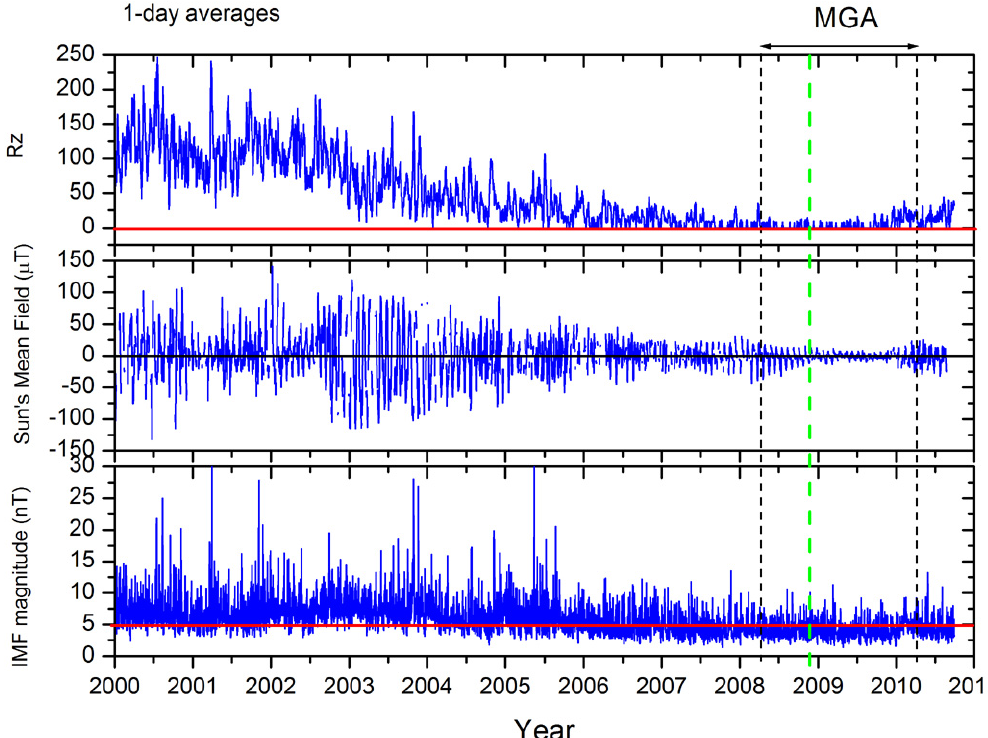
Fig. 3. The top panel is the sunspot number, R z , the middle panel the solar magnetic field magnitude and the bottom panel the interplanetary magnetic field at 1AU. The sunspot minimum is indicated by the vertical green line. The MGA23 interval is indicated above the graph and by the vertical dashed lines.